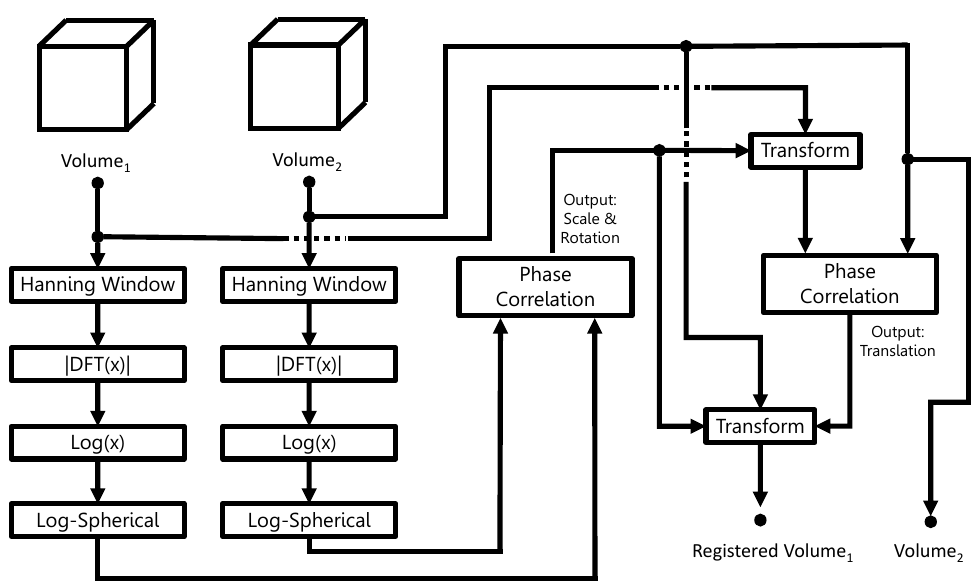
Figure 1. System Diagram for Registration